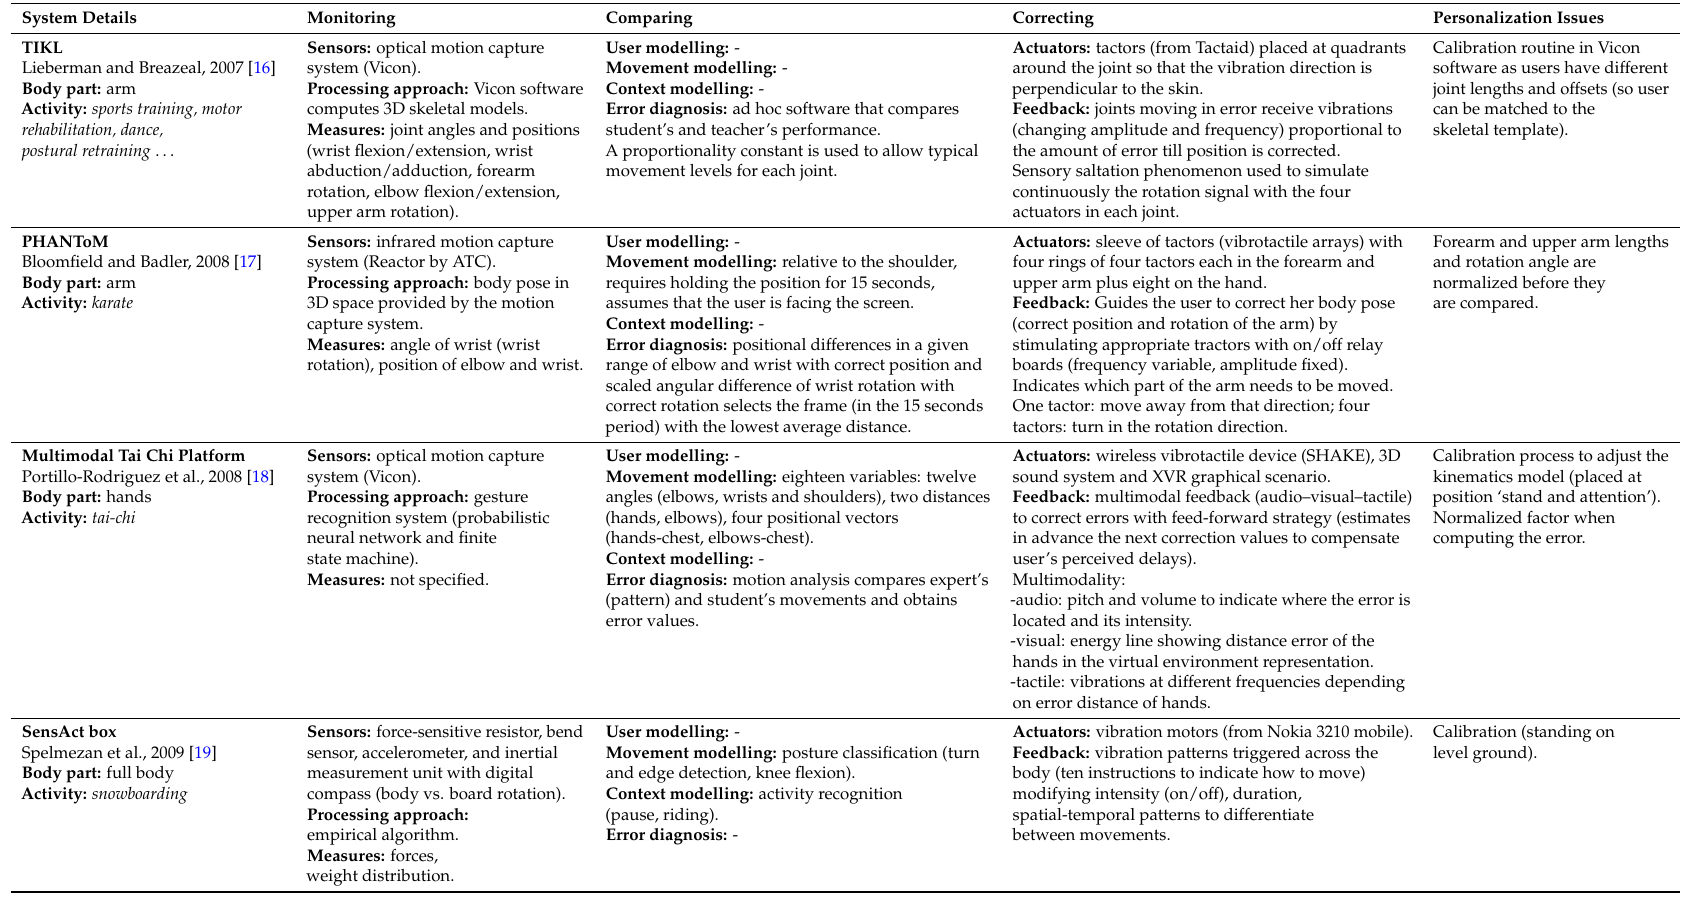
Table 1. Details of the six motor skills training systems reported in [9] that deliver vibrotactile feedback. System